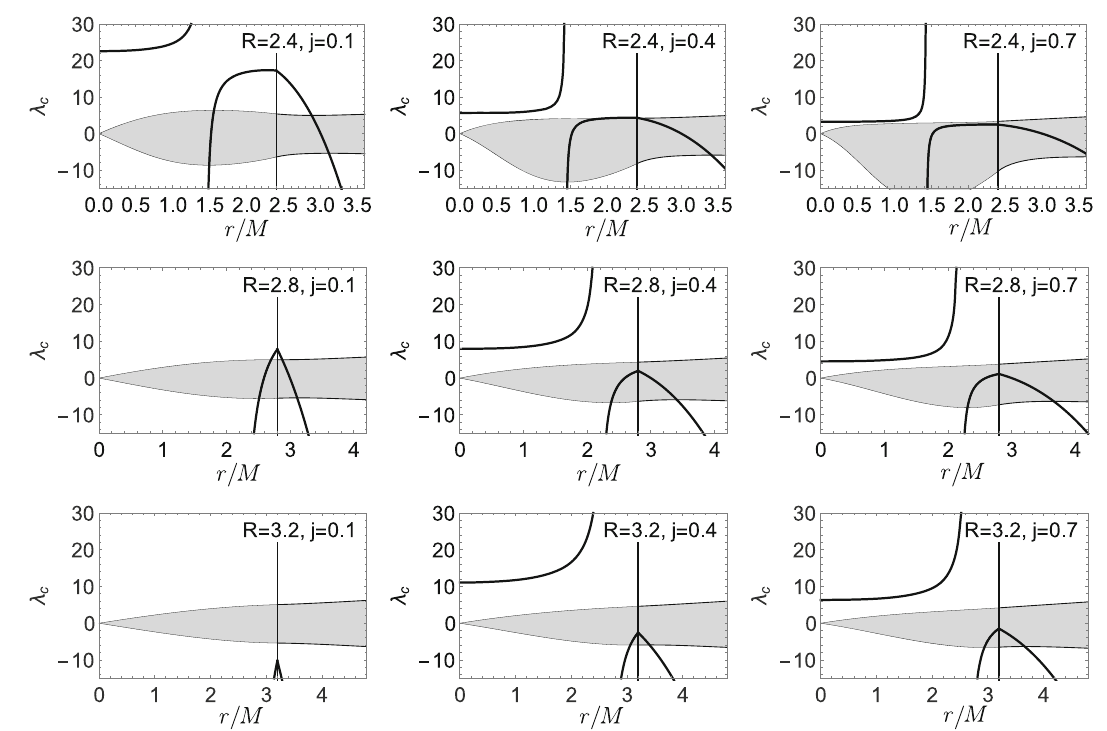
Fig. 5 Restriction for the values of λ and the function for λ c in the equatorial plane. The grey area indicates the allowed region for λ with theboundariesgivenby λ + and λ − .Theboldsolidlineshowsthevalues of λ c which marks the extremes of L . The first column is for j = 0 . 1,